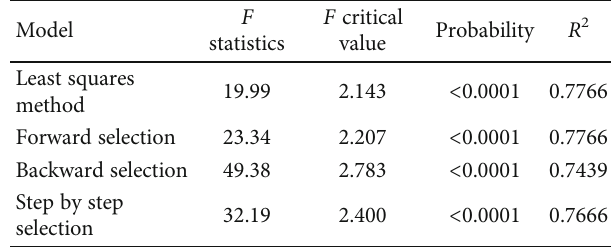
Table 3: Separation e ffi ciency model veri fi cation.